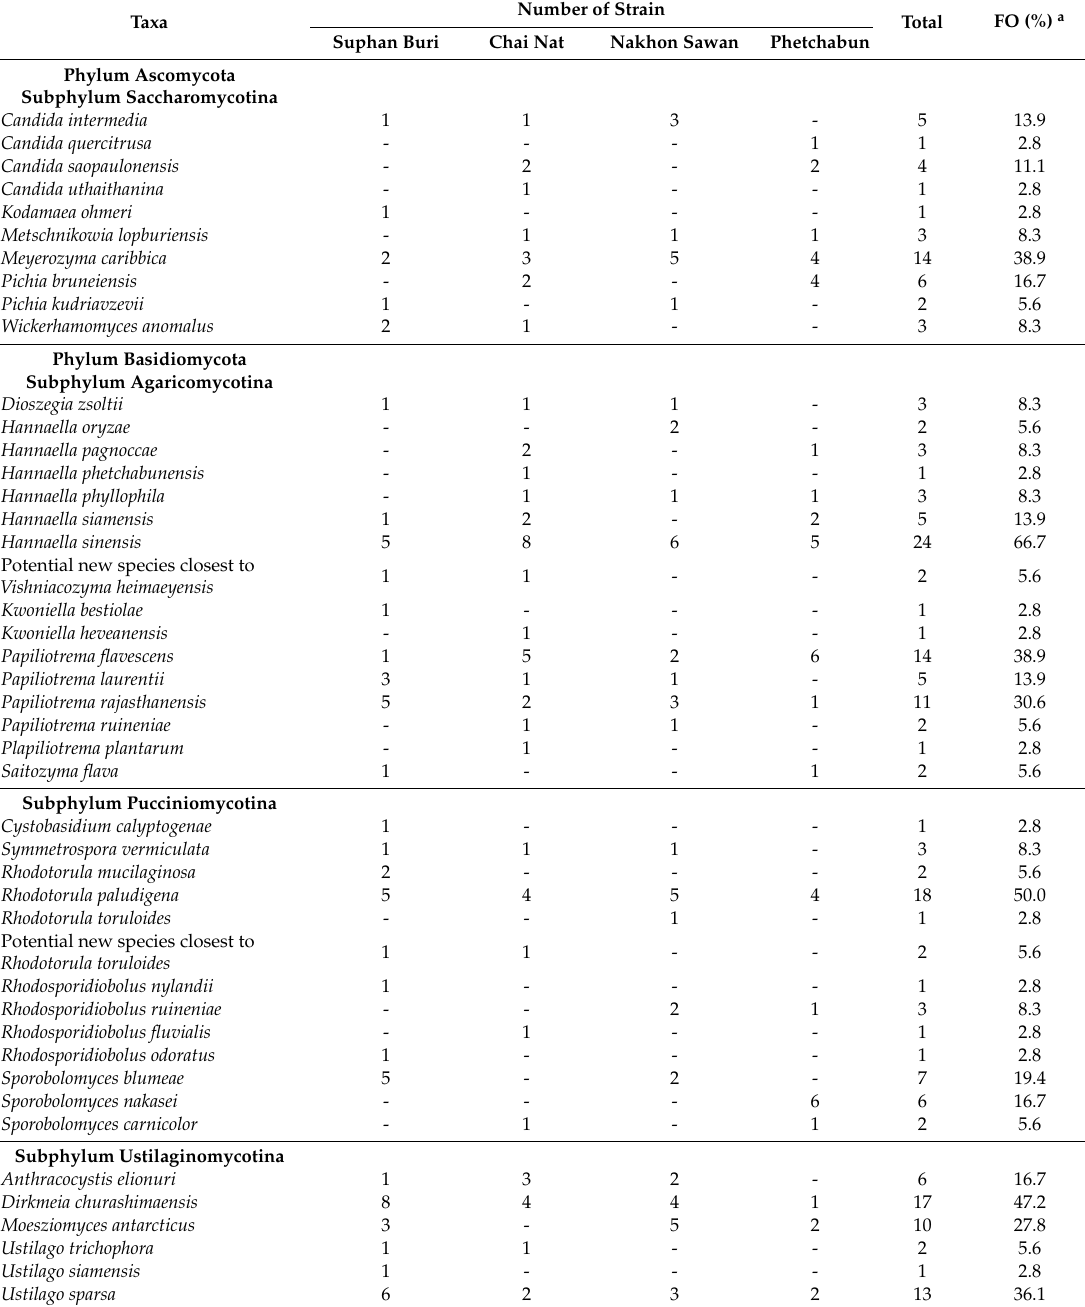
Table 2. Yeast species and respective frequencies detected on corn